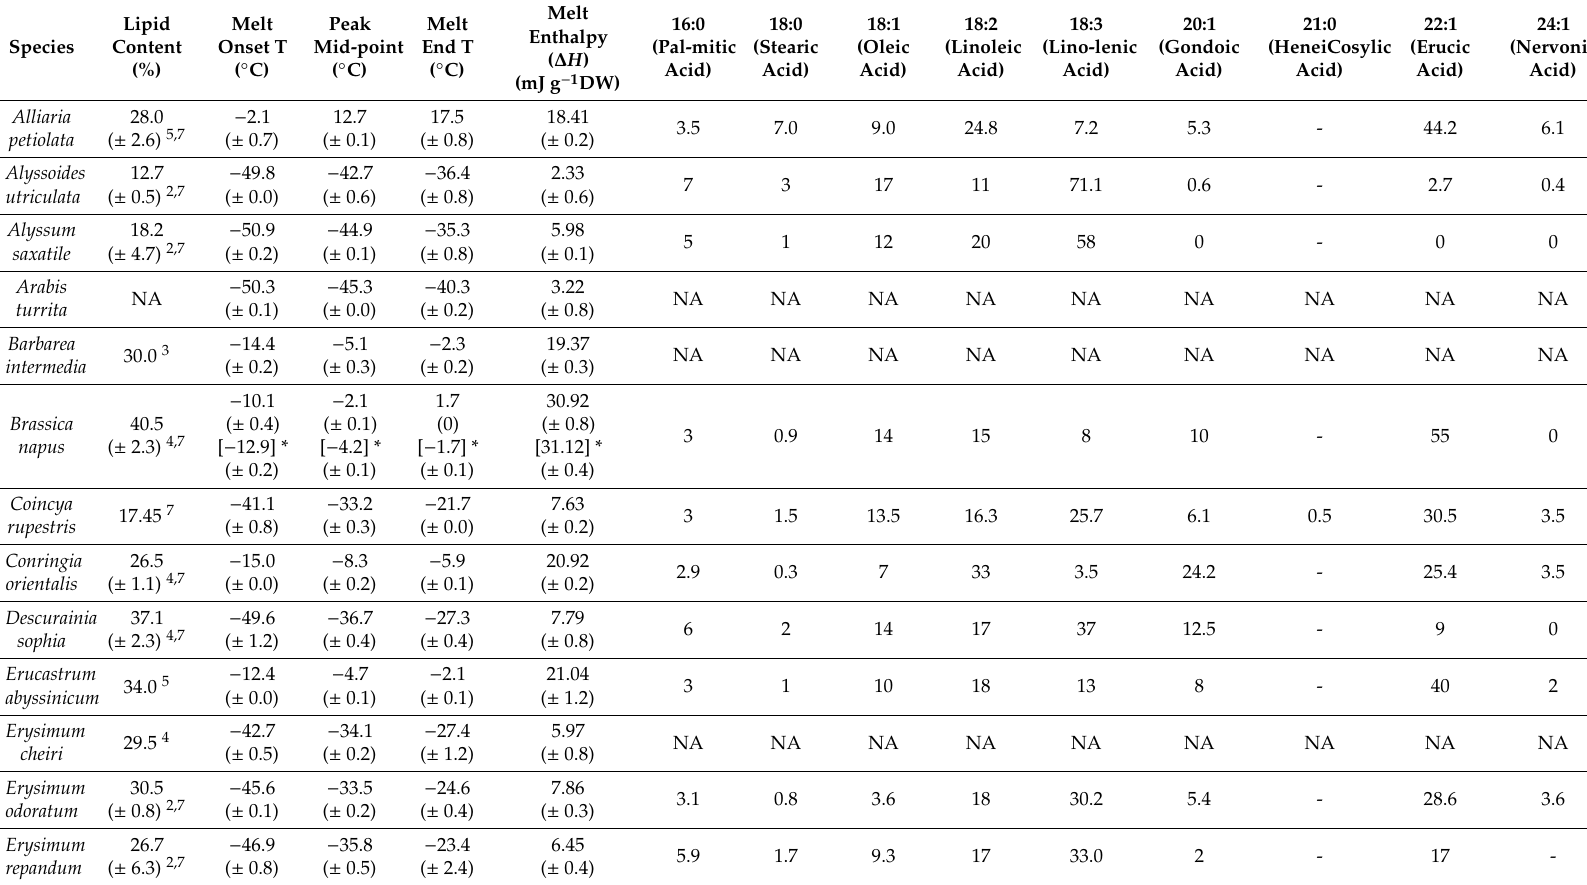
Table 2. Lipid content, fatty acid composition, and thermal analysis during warming at 10 ◦ C min − 1 of dry seeds of 20 Brassicaceae species after 43–44 years in